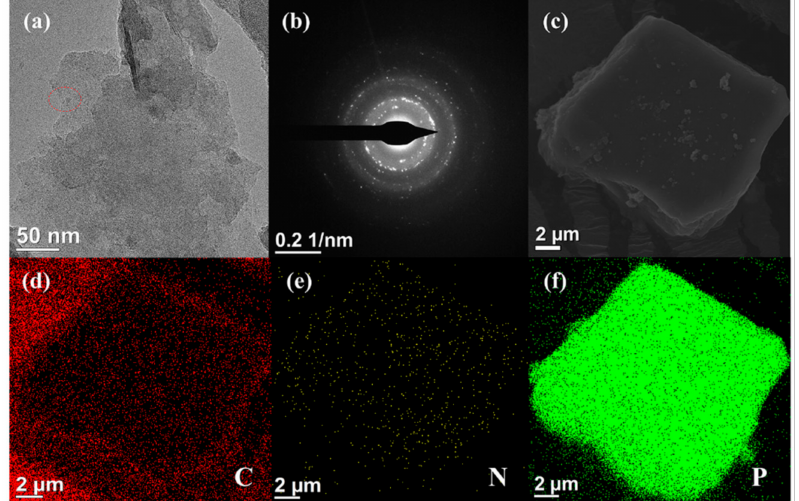
Figure 3. ( a ) TEM image and ( b ) SAED pattern of the BP nanosheets; ( c ) SEM image of BP-DETA nanosheets and the corresponding elemental mapping images of ( d ) carbon (C), ( e ) nitrogen (N), ( f ) phosphorus